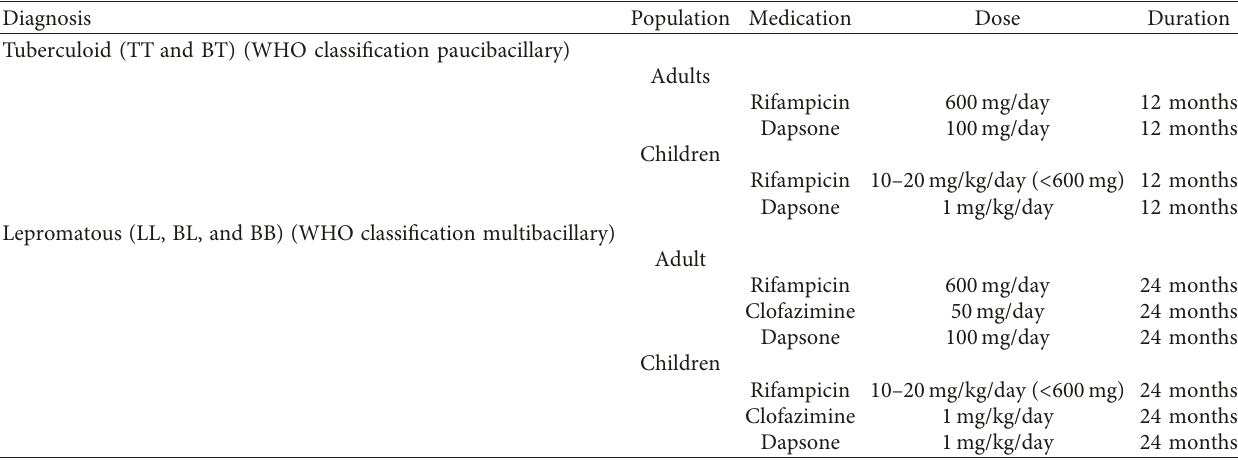
Table 4: Summarization of the treatment regimen recommended by the National Hansen’s Disease Program and the United States Health Resources and Services